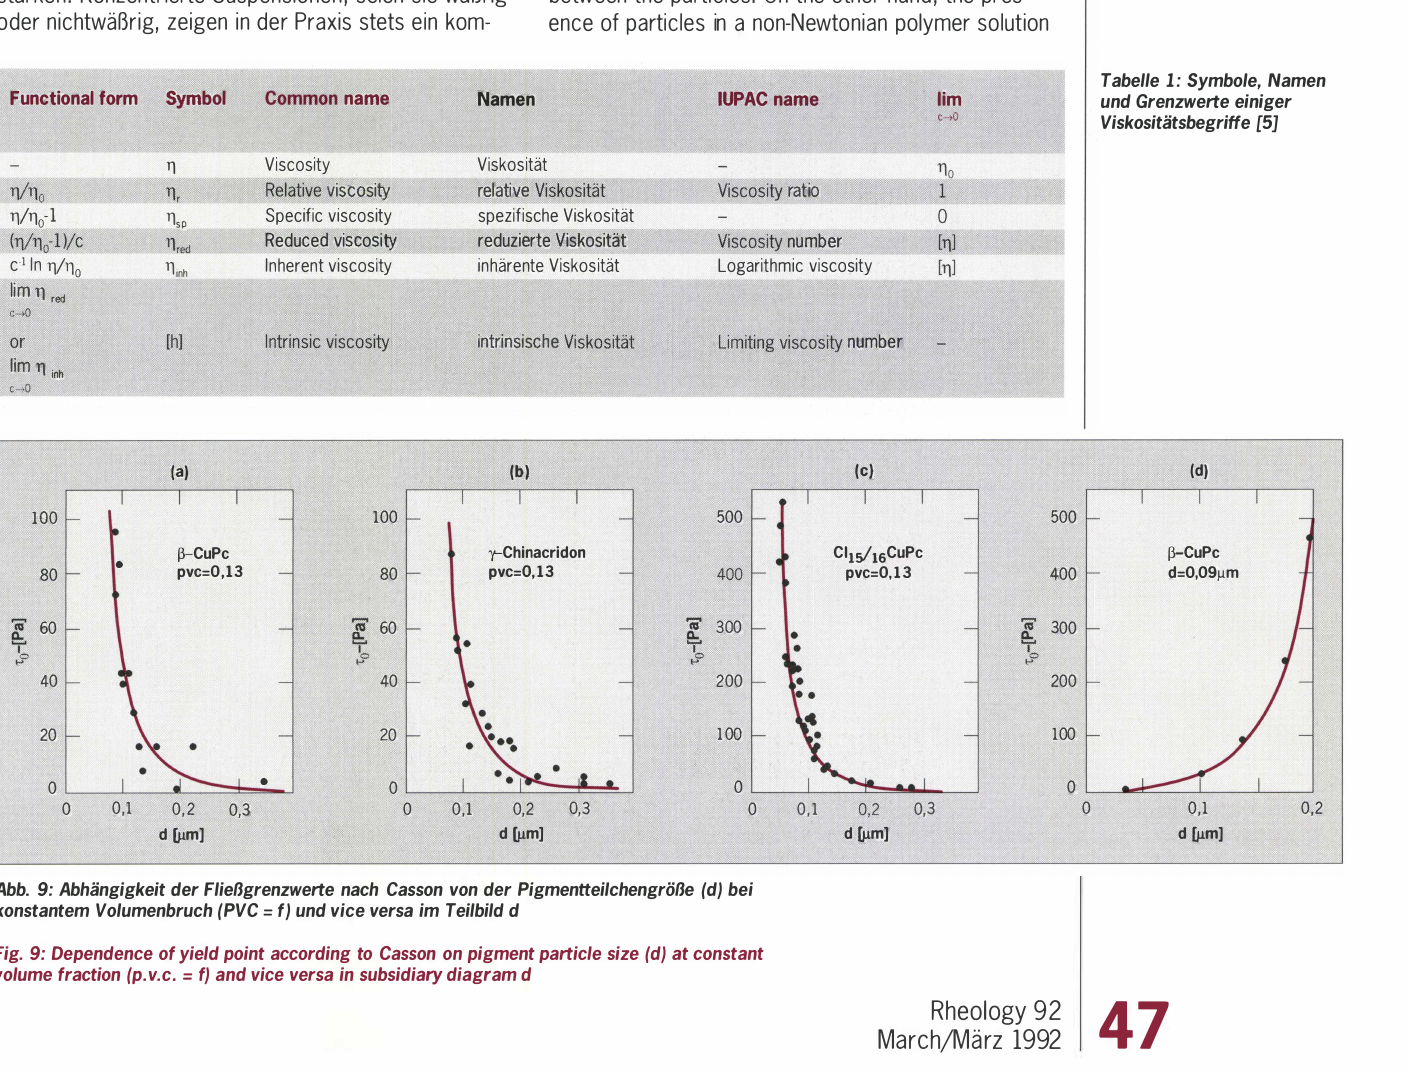
Fig. 9: Dependence of yield point according to Casson on pigment particle size (d) at constant volume fraction (p.v.c. = f) and vice versa in subsidiary diagram d